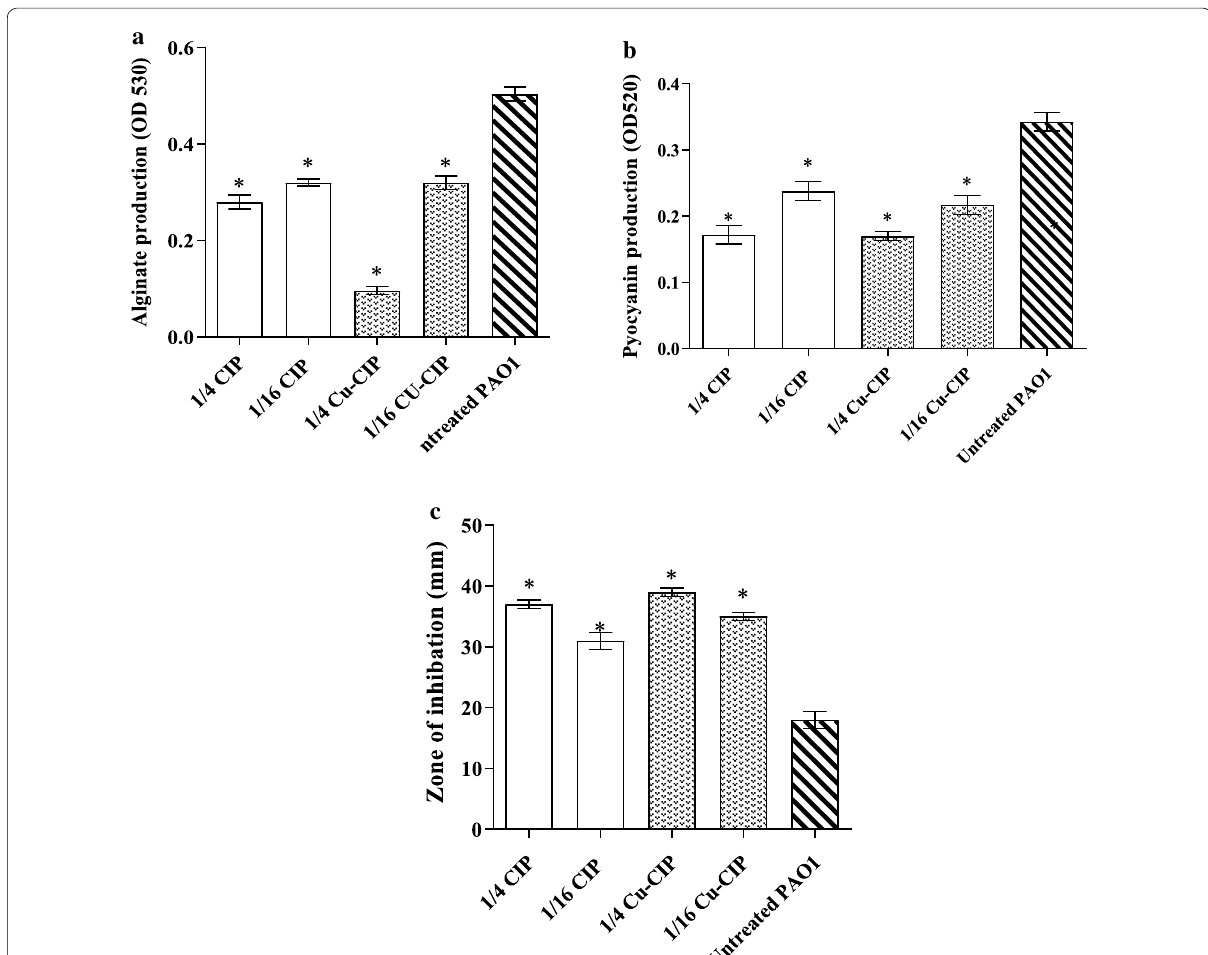
Fig. 5 Effect of subinhibitory concentrations (1/4 and 1/16 MIC) of ciprofloxacin (CIP) and copper-ciprofloxacin complex (Cu-CIP) on a the alginate